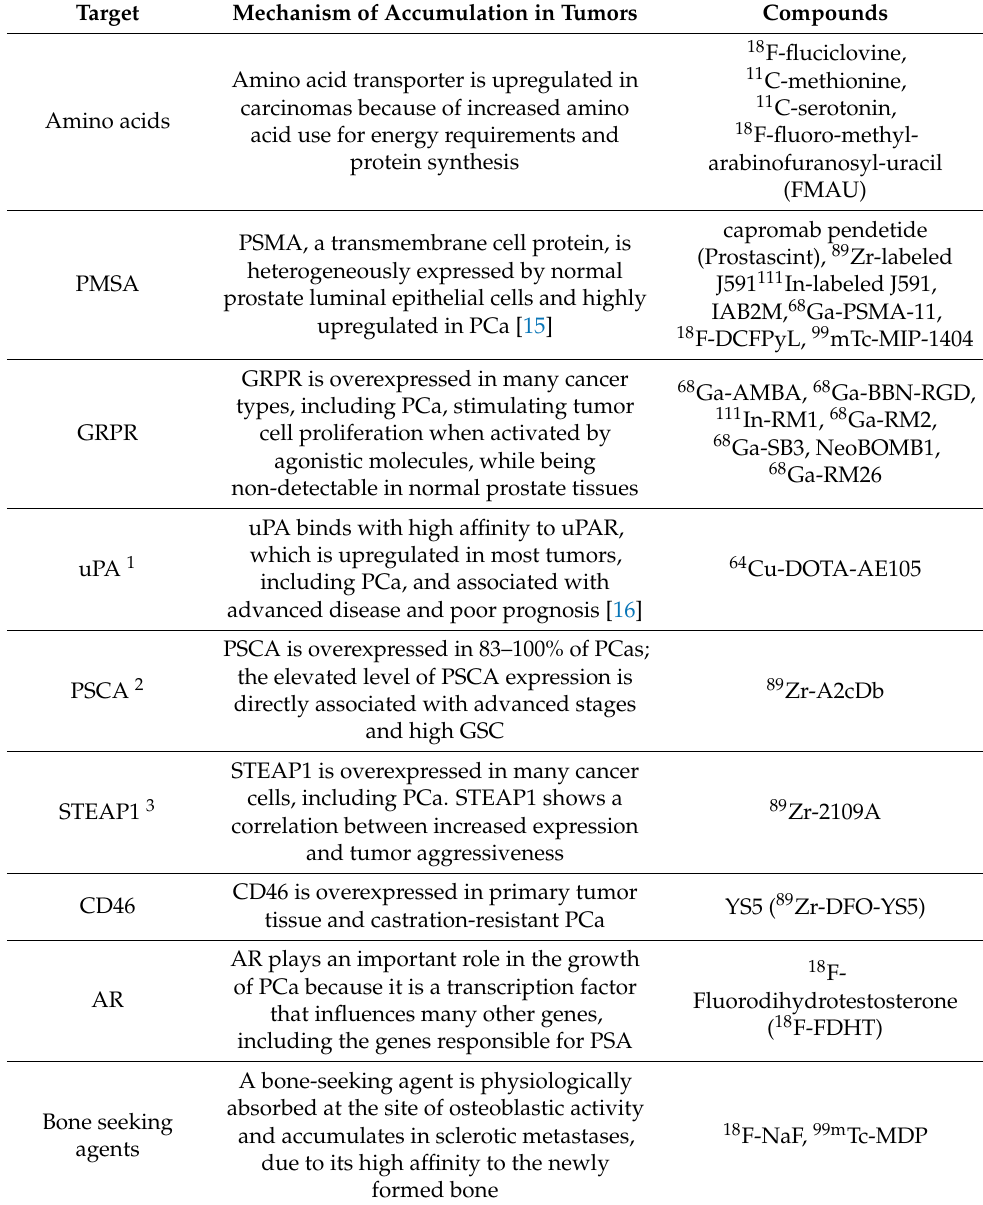
Table 1. Cont. Target Mechanism of Accumulation in Tumors Compounds Amino acid transporter is upregulated in carcinomas because of increased amino Amino acids acid use for energy requirements and protein